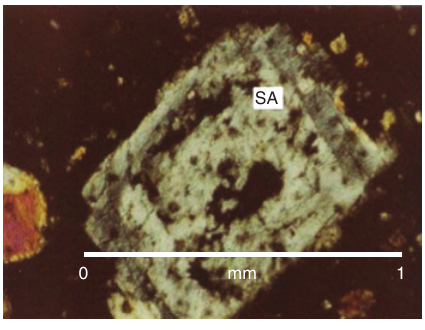
Figure 5 Zoned feldspar crystal within the Isparta-Karakaya